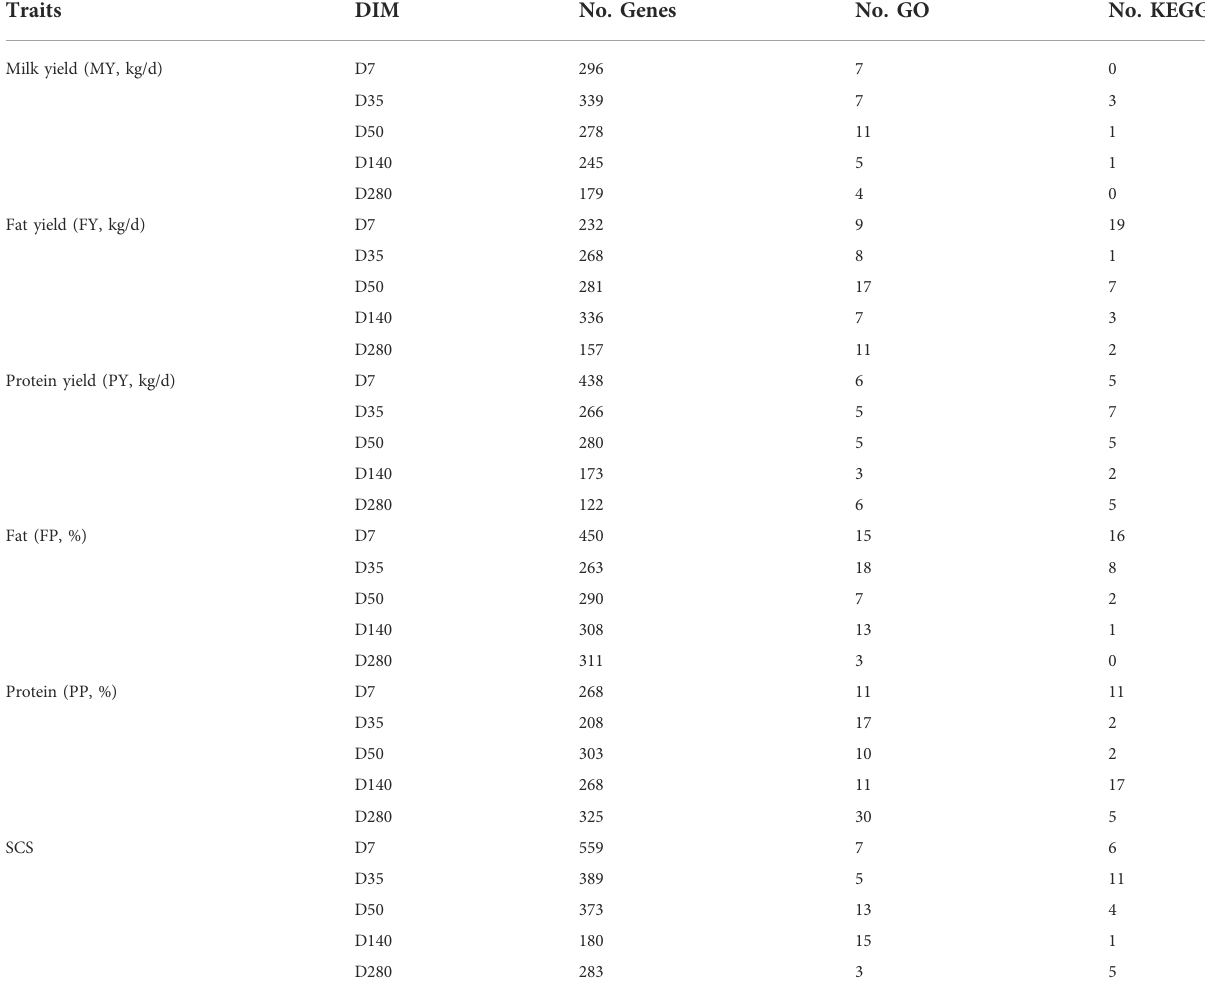
TABLE 2 Summary statistics for GO and KEGG associated with milk production in Shanghai Holstein population.